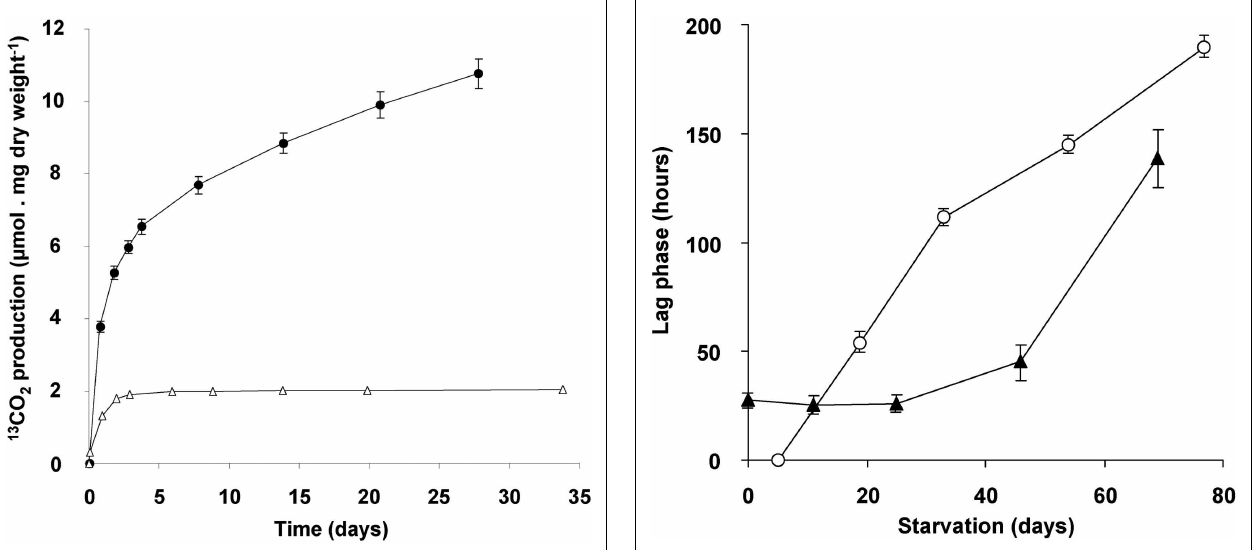
(closed circles). Exponentially growing cells (2.1mg dry weight; open triangles) served as a control. 13 CO 2 measured after 1h of incubation at 55˚C, was subtracted from all measured values during the experiment. Error bars represent SEM ( n = 4).